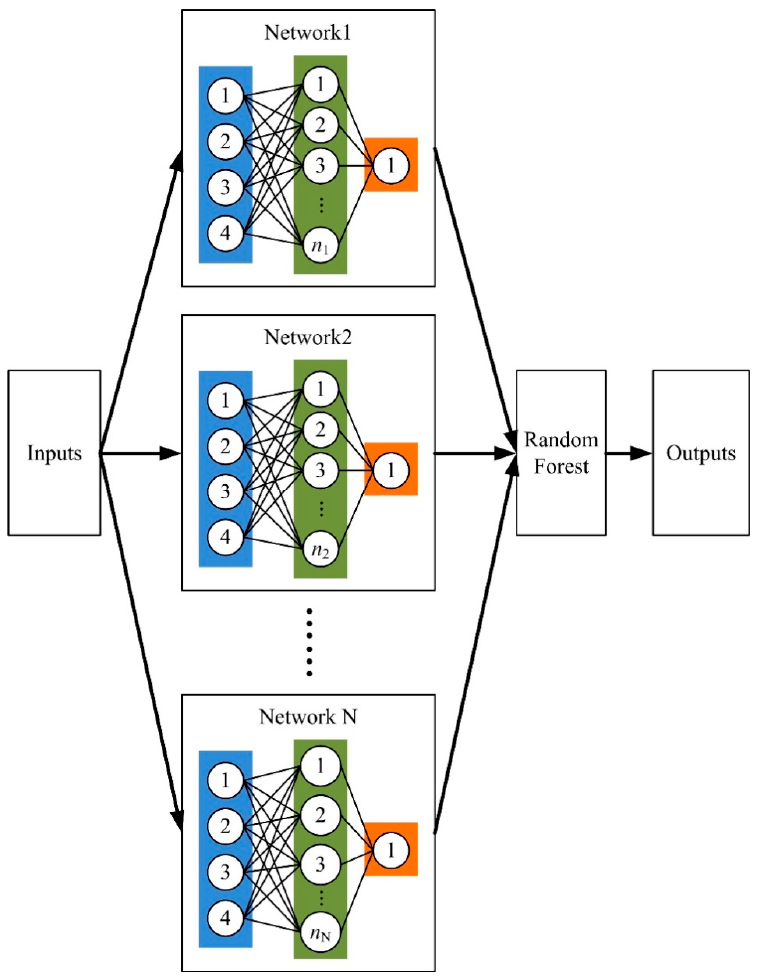
Figure 6. Construction of neural network ensemble (NNE).